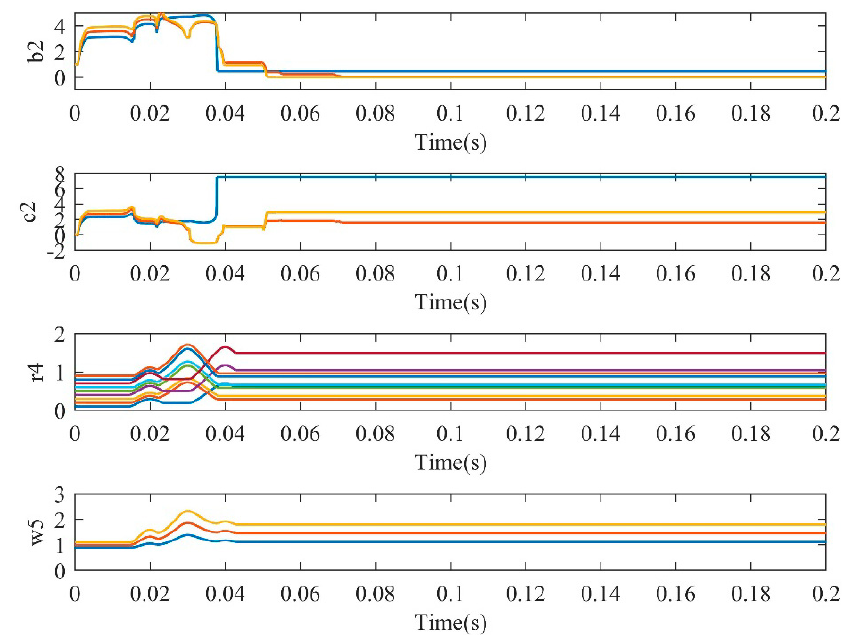
Figure 9. The first group of weights of adaptive learning curves.